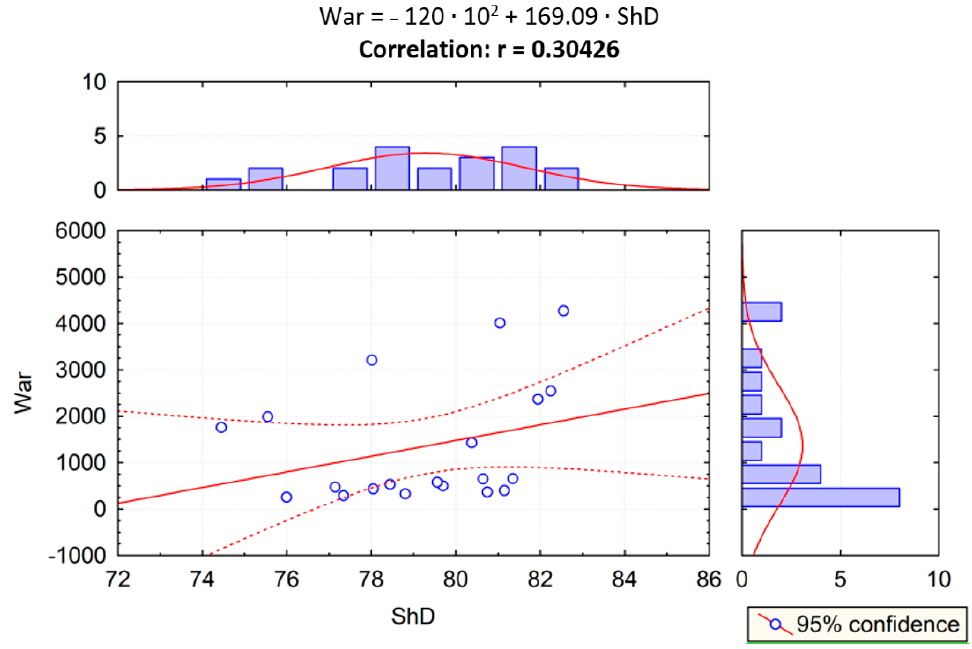
Figure 18. Dependence between cross-sectional area of sliding wear track W ar and Shore hardness ShD (r—correlation).